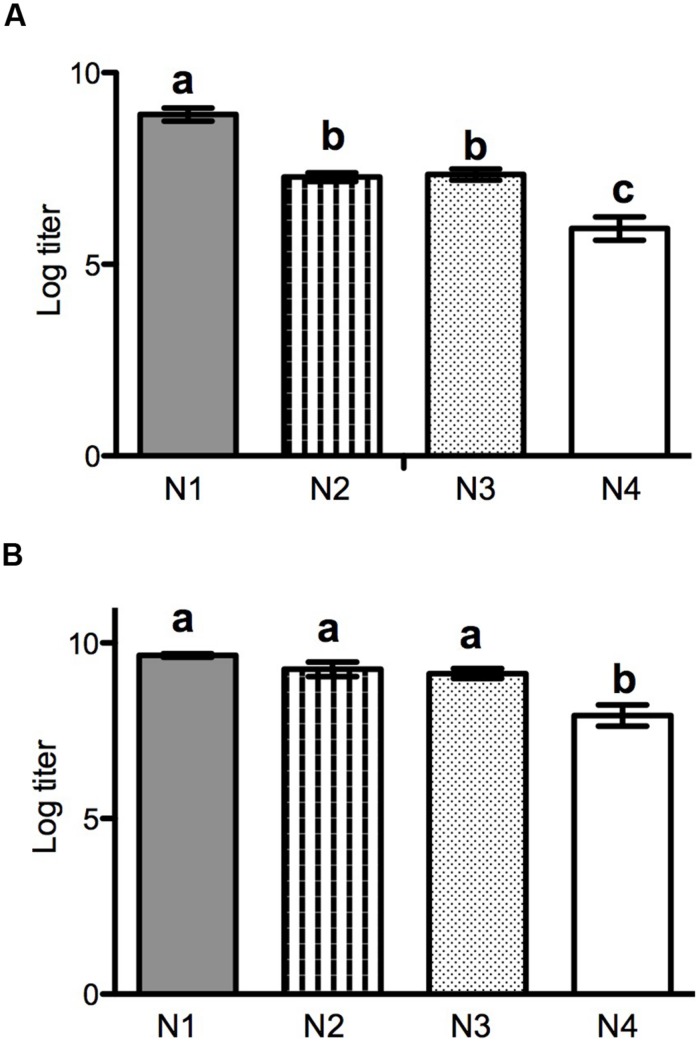
Reproductive output after 24 h growth in PC-3 (A) or LNCap (B) cells for N1–N4 ancestral strains. Output is shown as log titer produced (±SD, n = 3), as determined by plaque assay.